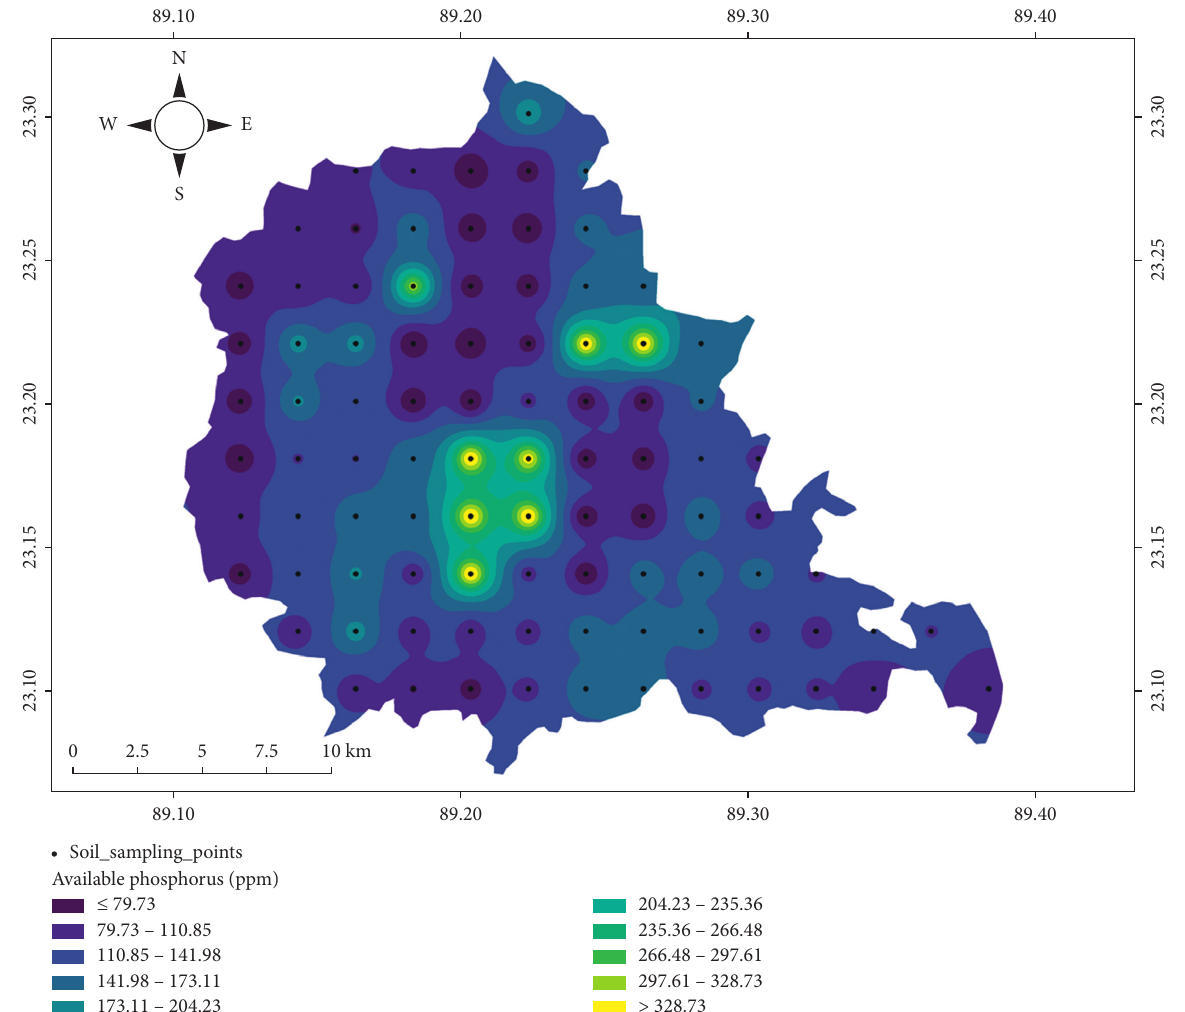
Figure 9: Spatial distribution of available soil phosphorus (Av P) contents in the study